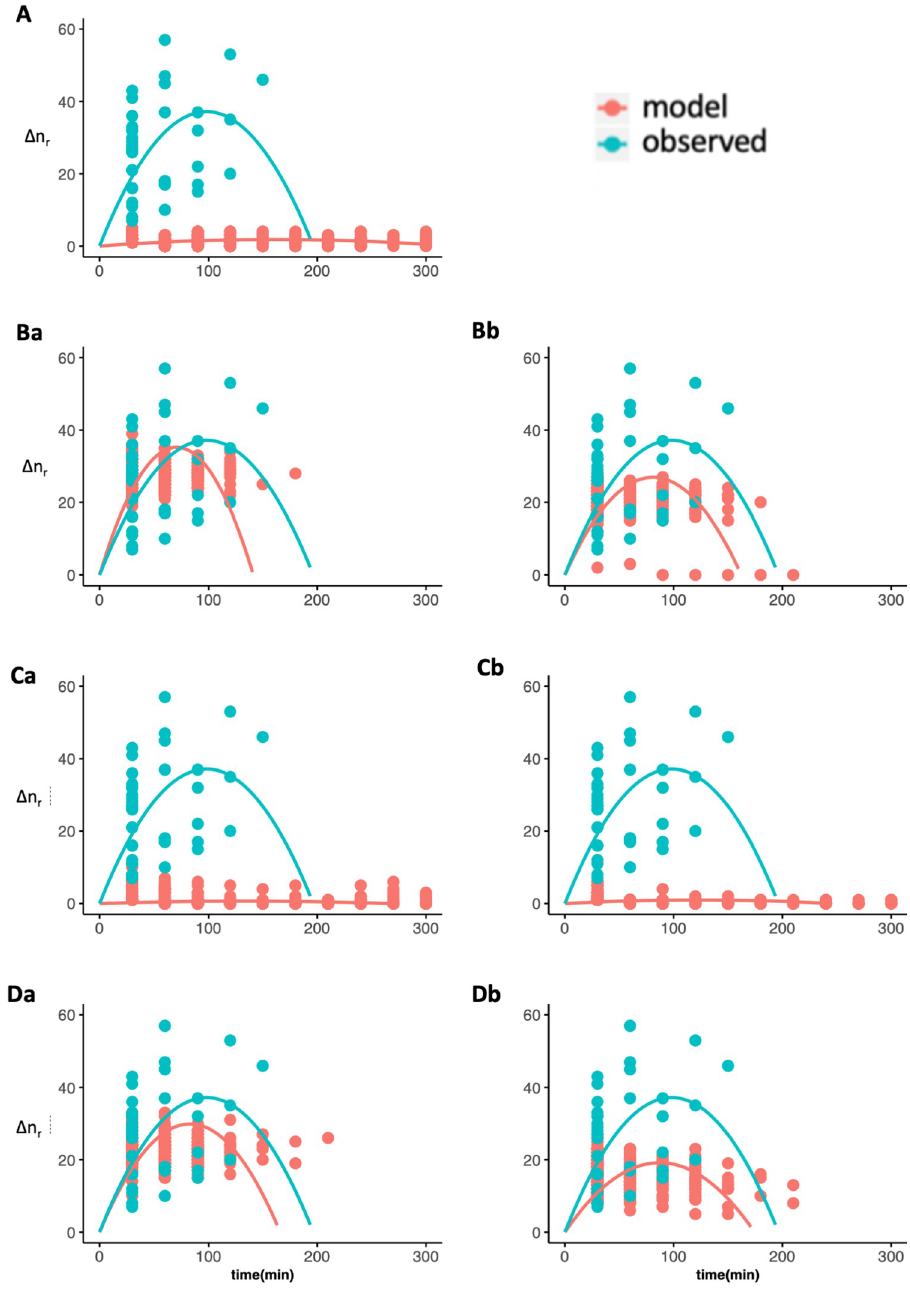
Fig 5. The change of the number of resting individuals in P m:r . The pink points are data obtained from simulation and blue are those from the observation. Data were fitted to a quadratic function that crosses (0,0), i.e., ax 2 +bx. R 2 is the coefficient of determination of the regression for simulated data. Aa: independent, Ba: absolute anonymous, Bb: proportional anonymous, Ca: unit-level absolute social, Cb: unit-level proportional social, Da: herd-level absolute social, and Db: herd-level proportional social